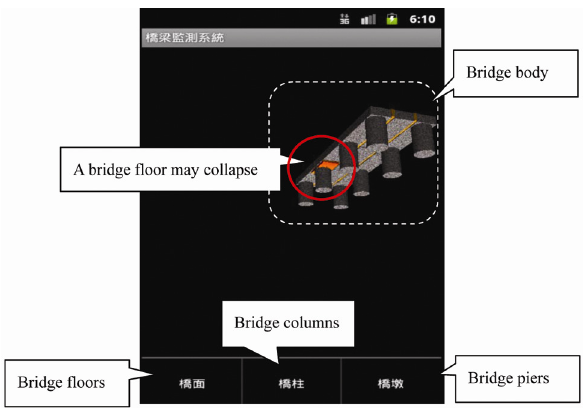
Fig. 7. Confirming bridge health through mobile 3D